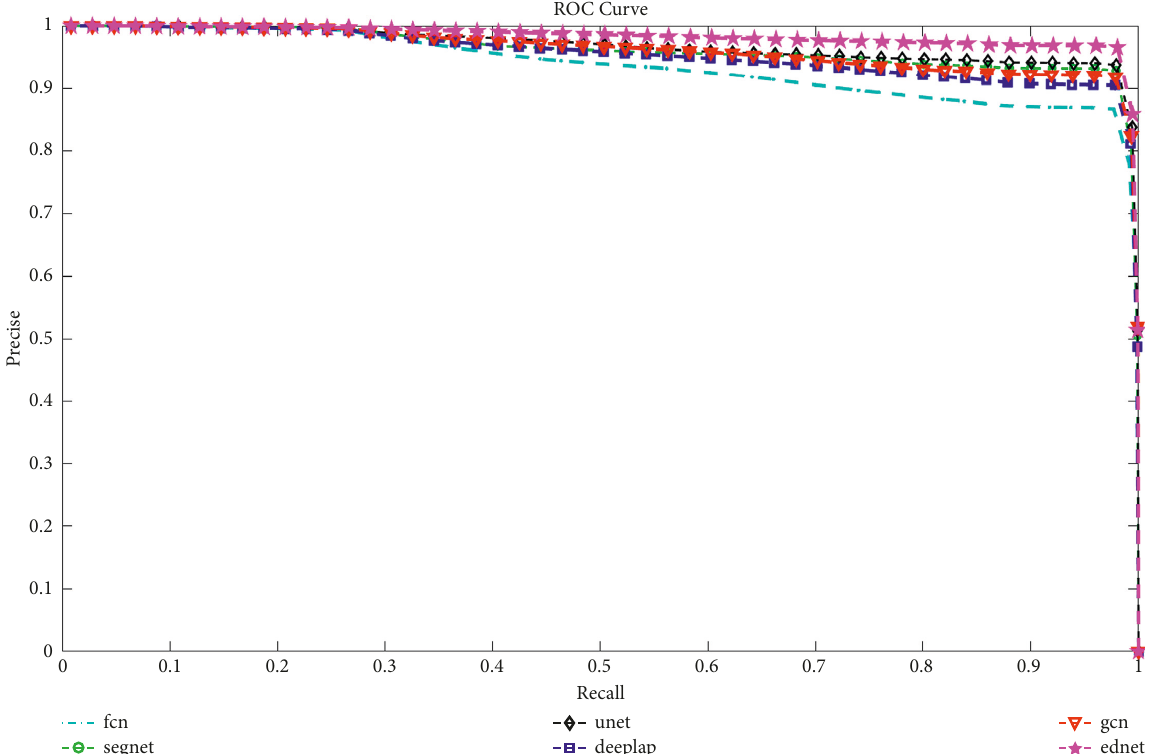
Figure 10: Semantic segmentation results of our method and other state-of-the-art methods on the insulator test set. The figure is the original image and the prediction results of each algorithm. From top to bottom are the original image, Ground Truth, FCN-8s, SegNet- VGG16, U-Net, DeepLabV3+, and GCN-ResNet152 and the last row is the prediction result of the network in this paper. The yellow box shows the details of the